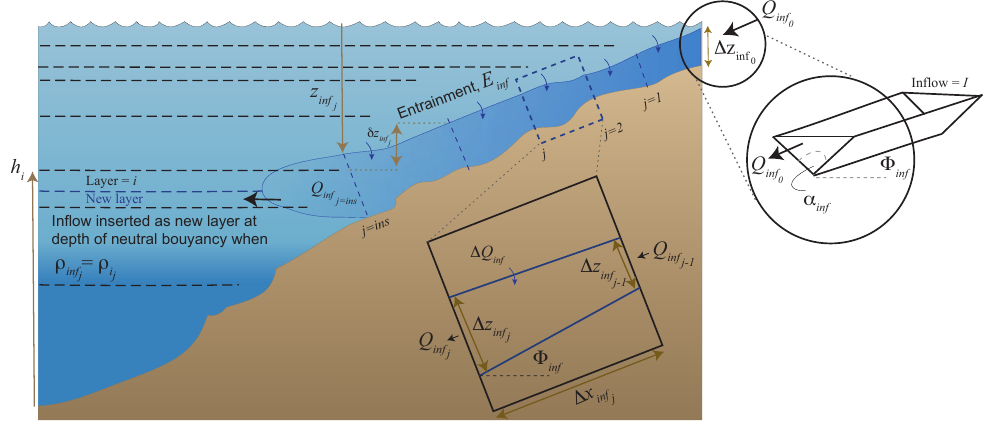
Figure 11. Schematic showing inflow insertion depth, entrainment, E inf , slope, (cid:56) inf , and bottom slope angle, α inf , of an inflowing river, I , and an estimated starting thickness of (cid:49)z inf entering at a flow rate of Q inf 0